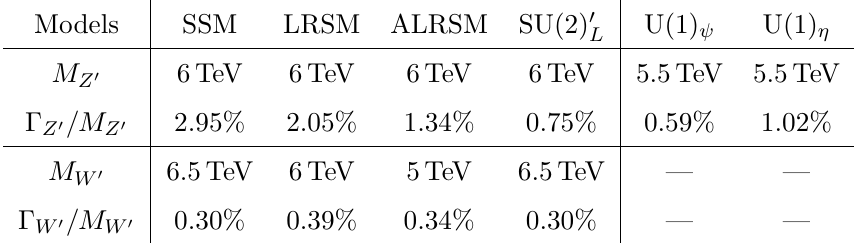
Table 2 . Extra gauge boson masses and widths adopted in our